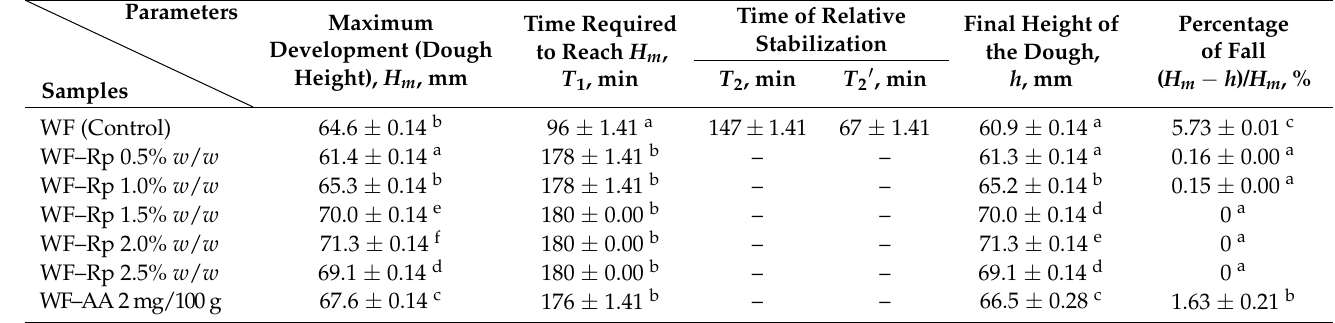
Table 2. Rheofermetographic properties of dough resulted from the dough development